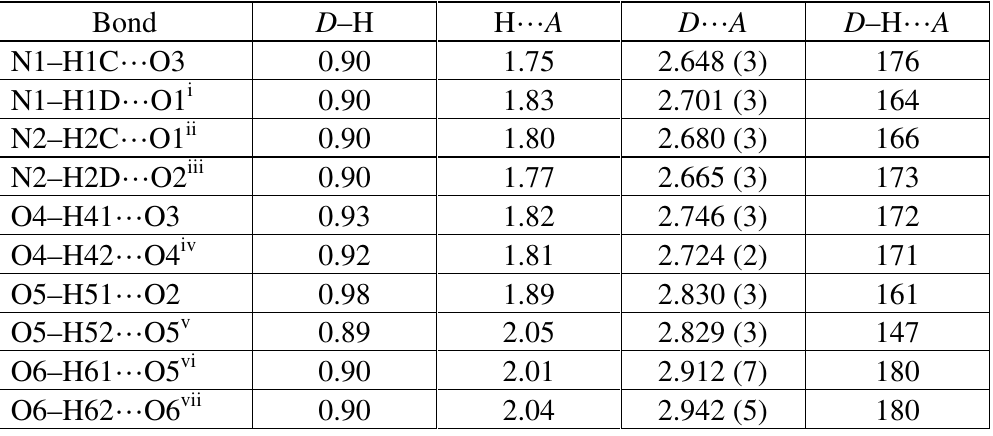
Table 2. Hydrogen-bond geometries for 2